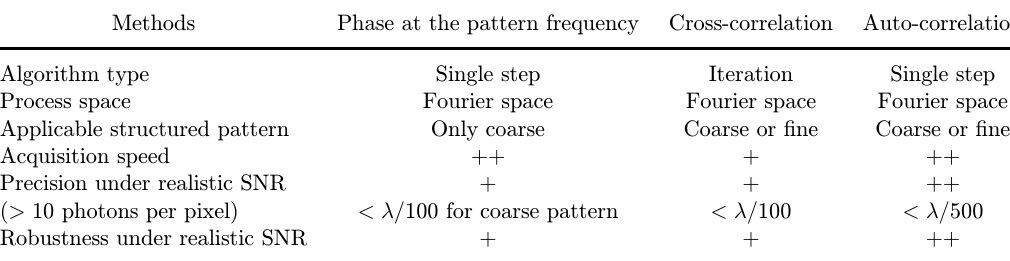
Table 1. Comparison of three deferent methods to retrieve the initial phase of structured pattern. 22 – 24